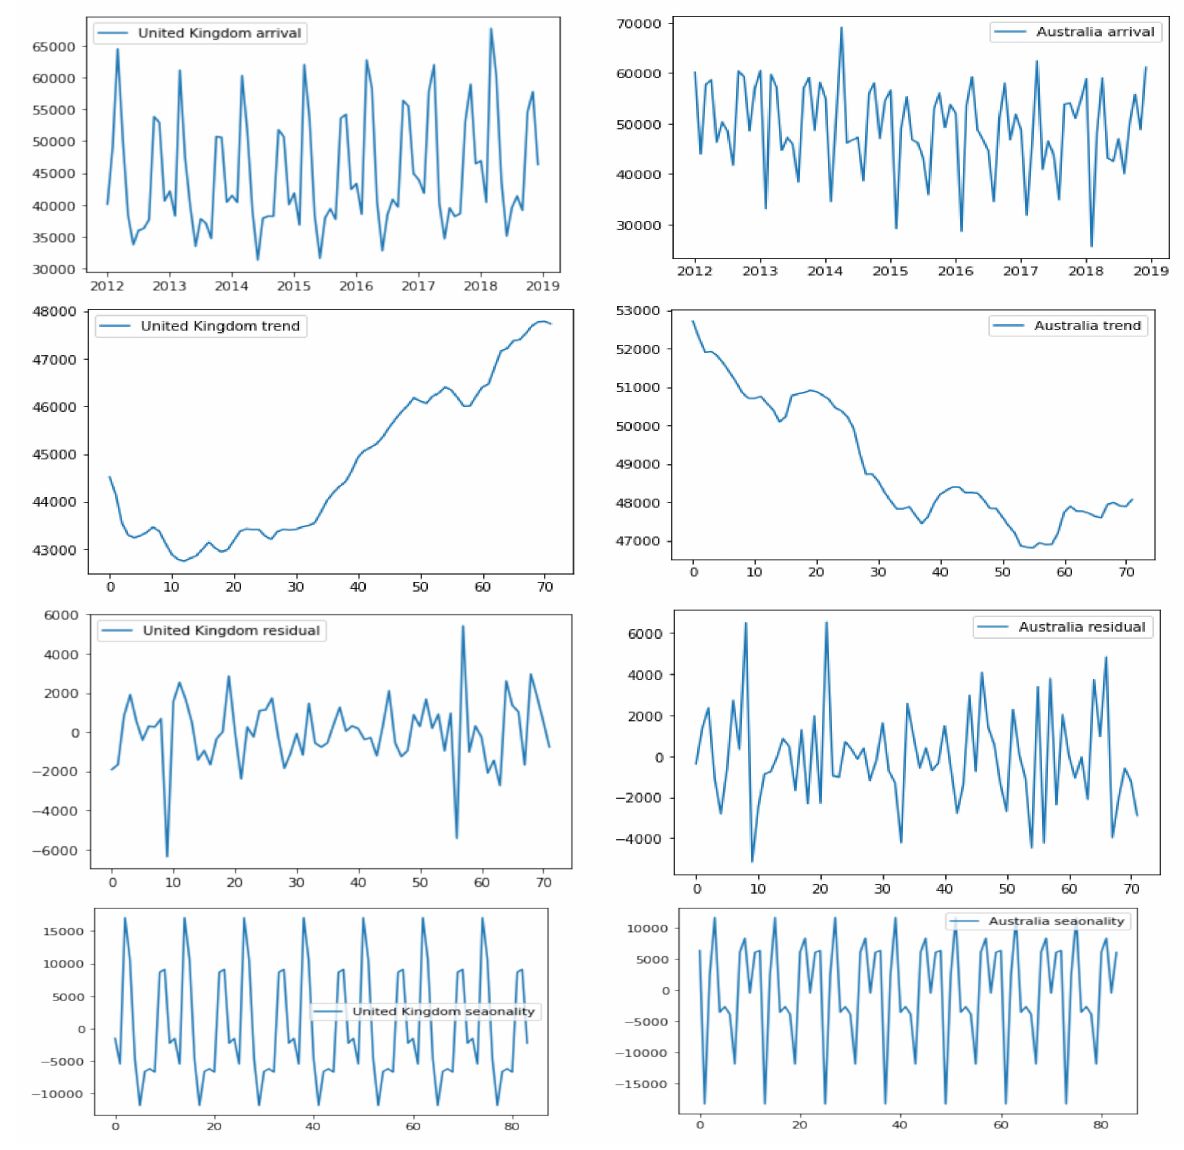
Figure 2. Trend, residual/error, and seasonality component after STL